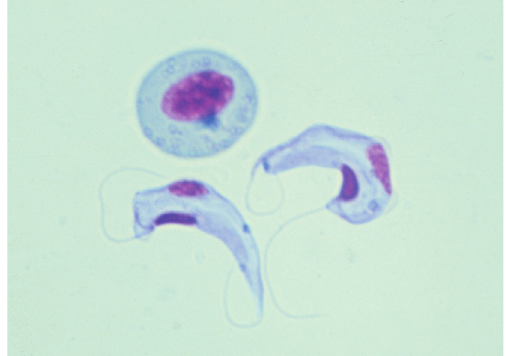
Figure 2: Exophthalmia in rainbow trout with an acute experimen- tal cryptobiosis (reproduced from Woo [5]).